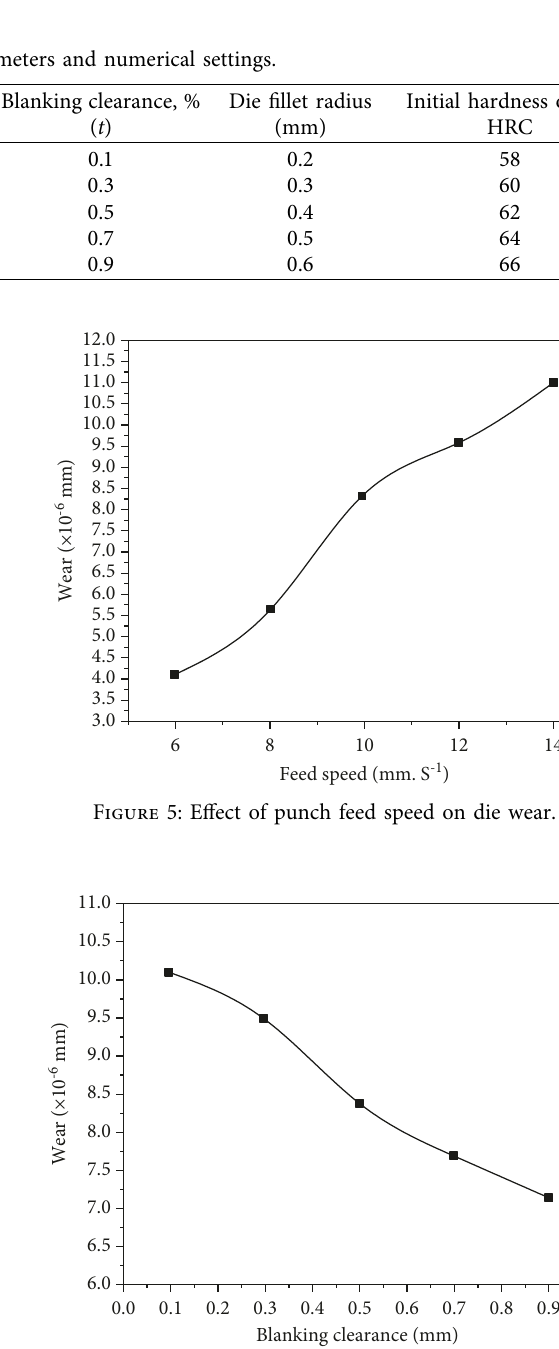
Figure 6: Effect of blanking clearance on die